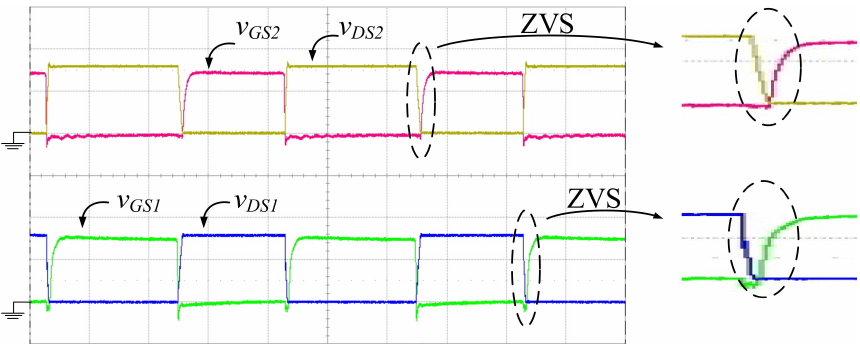
Figure 6. Voltage waveforms of active switches. ( v GS1 and v GS2 : 10V / div, v DS1 and v DS2 : 200 V / div, Time: 5 µ s / div).